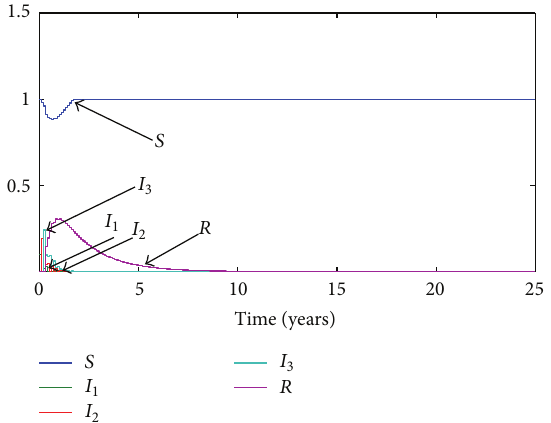
Figure 6: Dynamics model of the subpopulations of the 𝑆𝐼(3)𝑅 for = 0.92 . Observe that the subpopulations rapidly tend to the 𝑅 0 disease-free equilibrium.